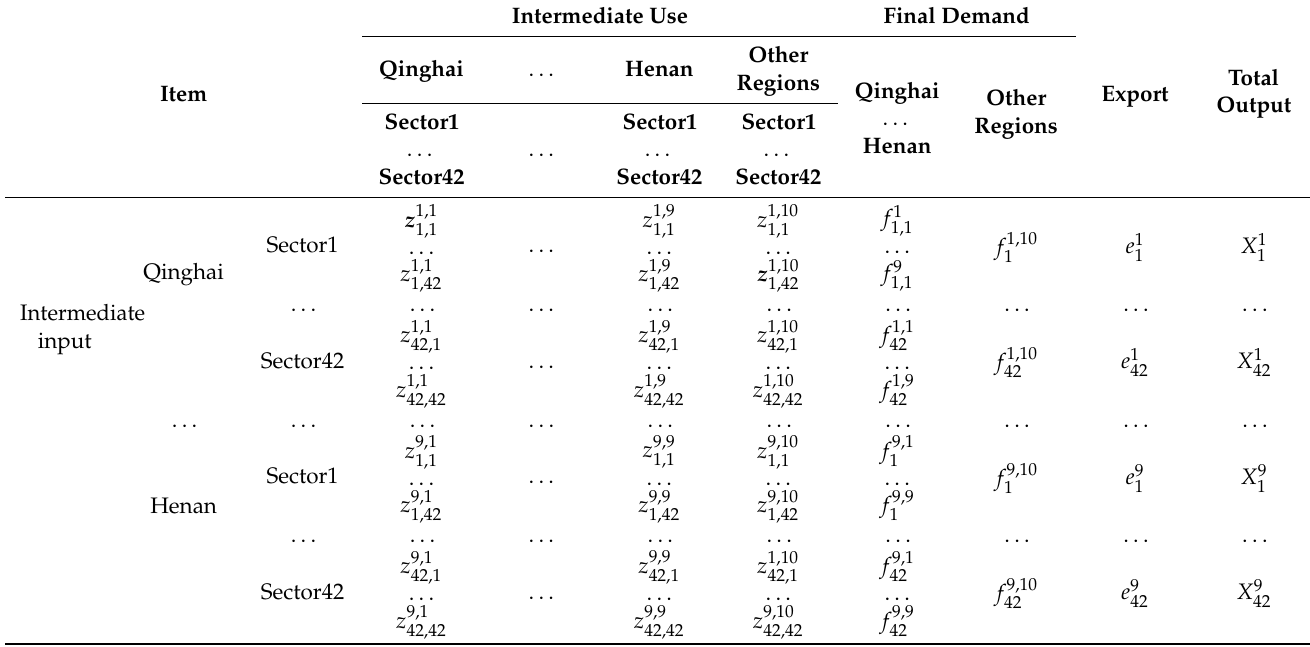
Table 2. Summary table of multi-regional input–output in the Yellow River